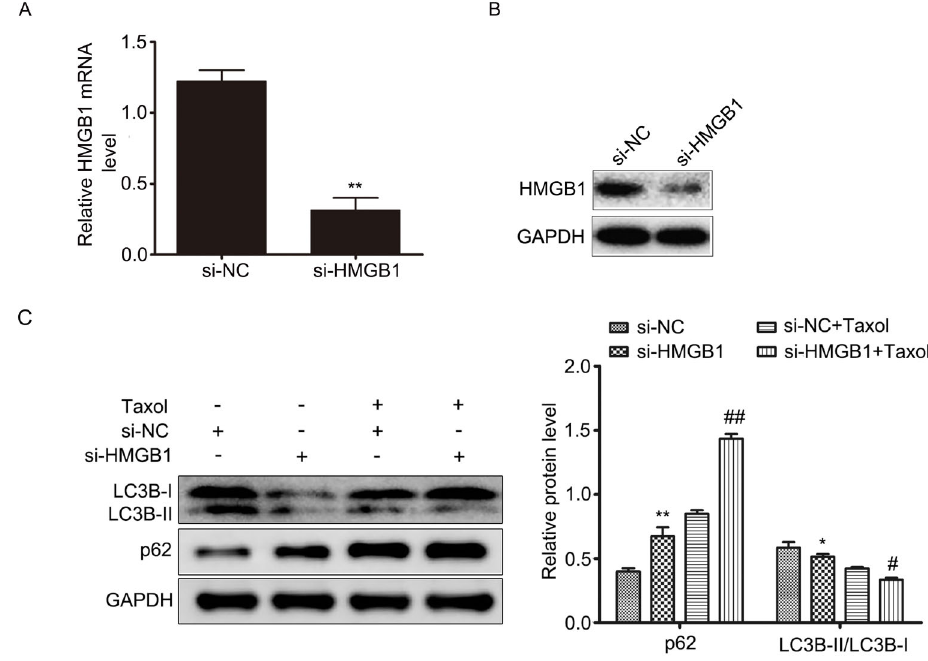
Figure 5. Interference of HMGB1 enhanced chemosensitivity of Taxol by inhibiting autophagy in MCF-7 cells. MCF-7 cells were transfected with si-HMGB1 or si-NC. A , Relative expression of HMGB1 mRNA was detected by qRT-PCR. B , Relative expression of HMGB1 protein was detected by western blot. C , MCF-7 cells were transfected with si-HMGB1 or si-NC and then treated with 31.2 nM Taxol for 24 h. LC3B-I, LC3B-II, and p62 expressions in cells were determined via western blot. Data are reported as means ± SD of three independent experiments. *P o 0.05, **P o 0.01, vs s i-NC group; # P o 0.05, ## P o 0.01, vs si-NC + Taxol group